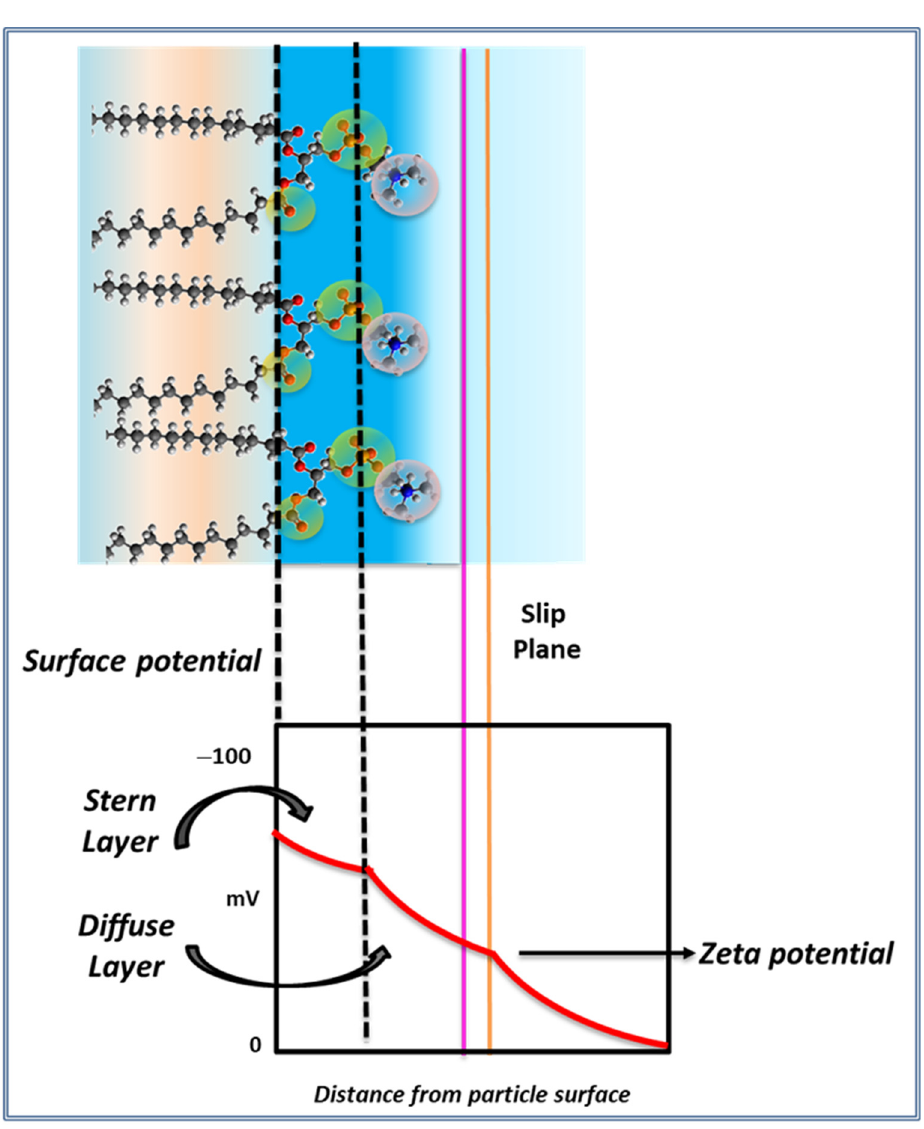
Figure 2. Electrical potential at the membrane surface.